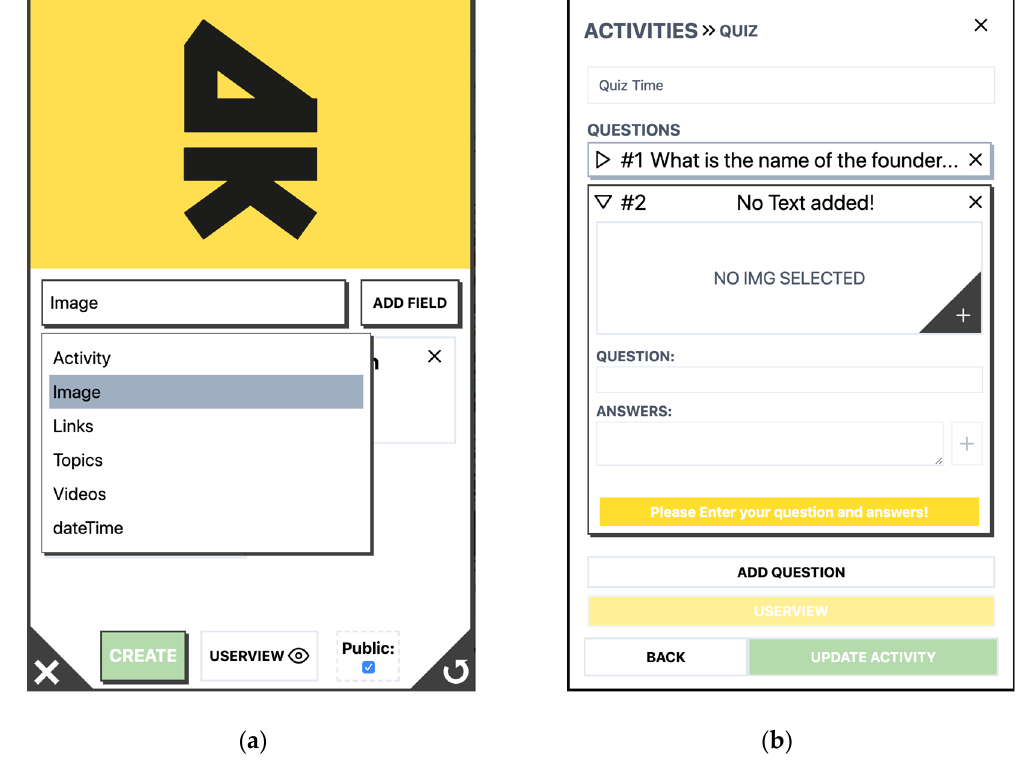
Figure 6. (a) Card Editor—Adding an image field; (b) Card Editor—Creating a quiz challenge.